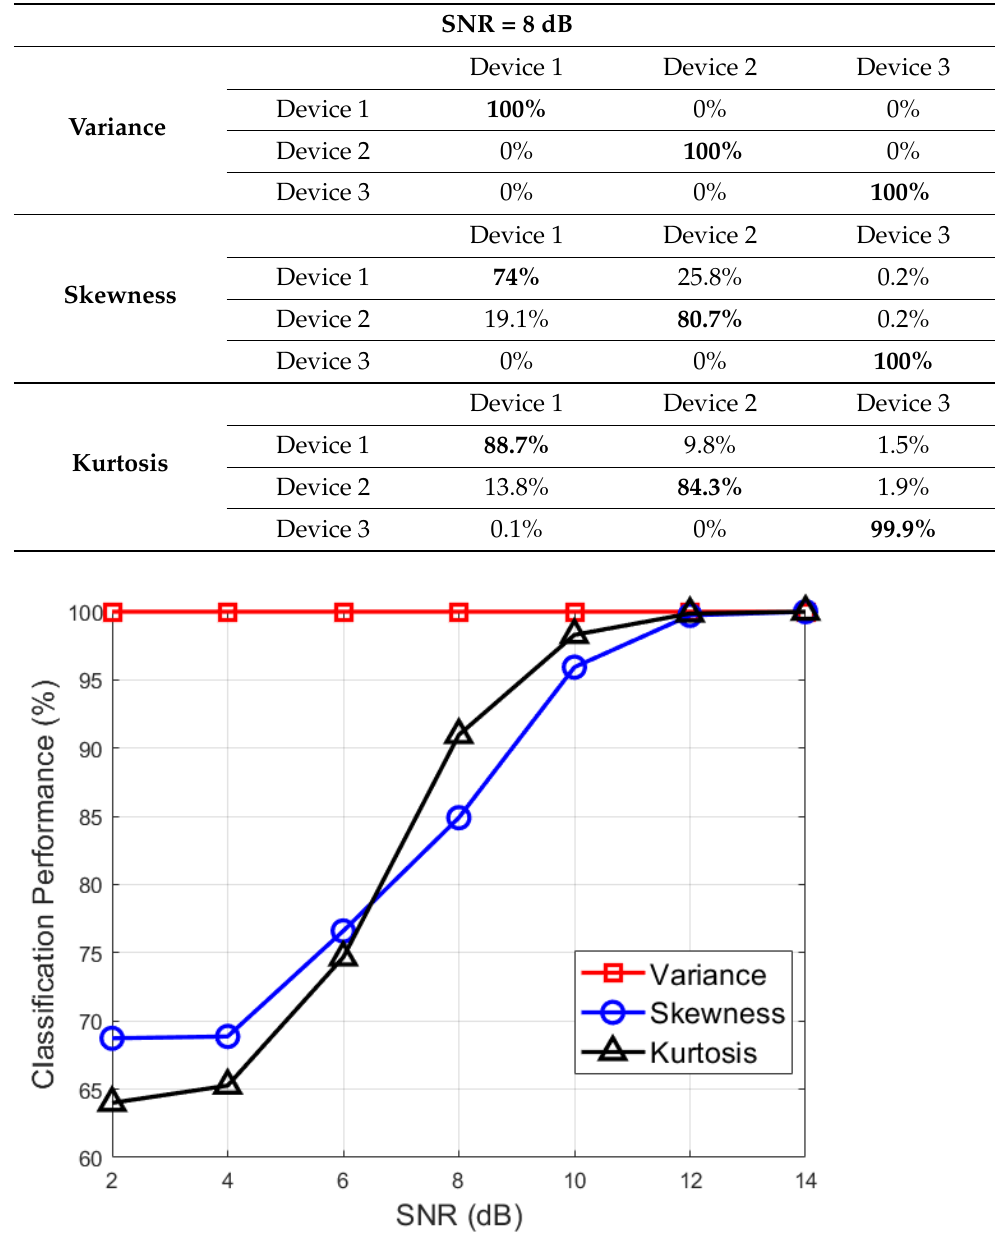
Table 1. Confusion matrices for statistical features in first, second, and third harmonic space for SNR = 8 dB.